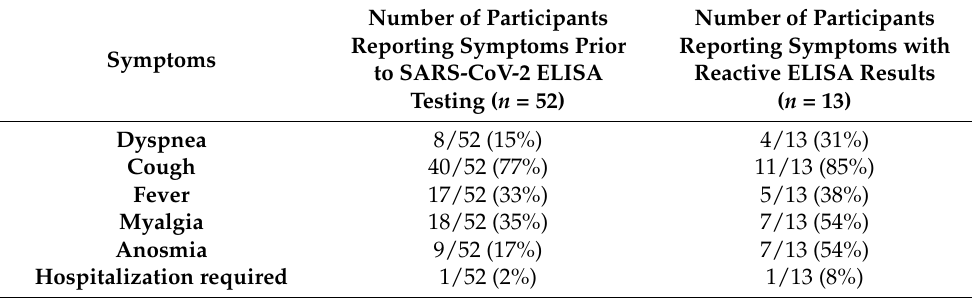
Table 1. Overview of the symptoms reported by the participants. Overall, 26.3% (52/198) of partici- pants reported symptoms prior to sampling; 25% of participants who reported symptoms (13/52) showed reactive ELISA results. SARS-CoV-2, severe acute respiratory syndrome coronavirus-2. Number of Participants Number of Participants Reporting Symptoms with Reporting Symptoms Prior Symptoms Reactive ELISA Results to SARS-CoV-2 ELISA ( n = 13) Testing ( n = 52) Dyspnea 8/52 (15%) 4/13 (31%) Cough 40/52 (77%) 11/13 (85%) Fever 17/52 (33%) 5/13 (38%) Myalgia 18/52 (35%) 7/13 (54%) Anosmia 9/52 (17%) 7/13 (54%) 1/52 (2%) 1/13